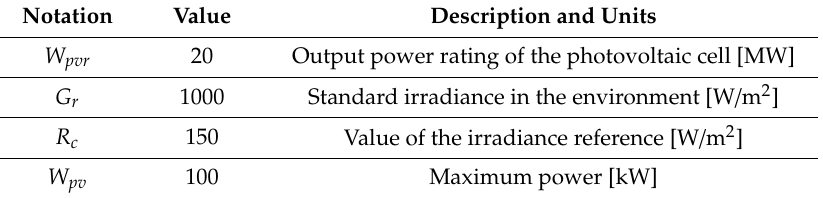
Table 6. Parameters of the photovoltaic system (for F 4 ( x ) calculation).